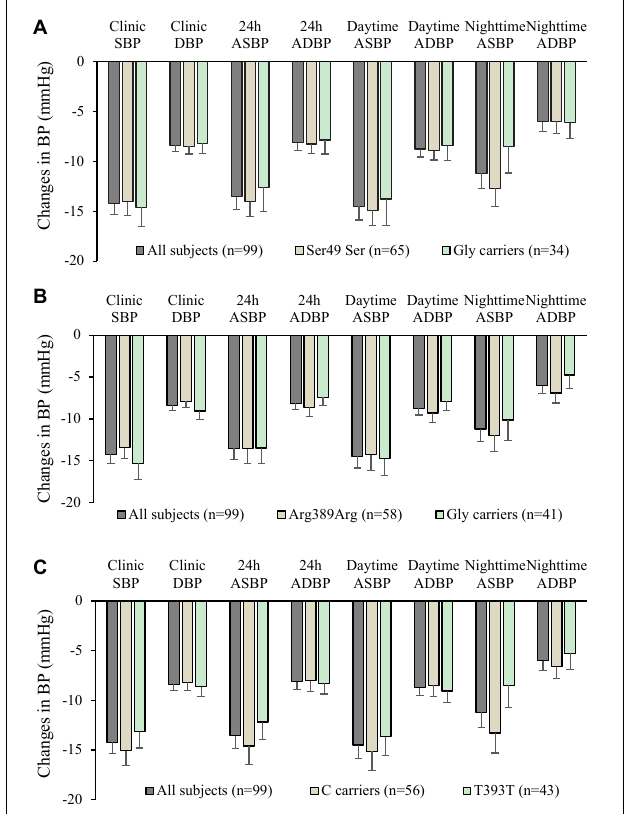
FIGURE 2 | Changes in clinic and ambulatory blood pressure after 6 weeks treatment with bisoprolol 2.5 mg daily according to (A) ADRB1 Ser49Gly genotypes, (B) ADRB1 Arg389Gly genotypes, and (C) The G protein α -Subunit 1 gene ( GNAS ) 393C > T genotypes. Data are presented as mean ± SEM. There is no significant difference between groups (independent samples test was used).